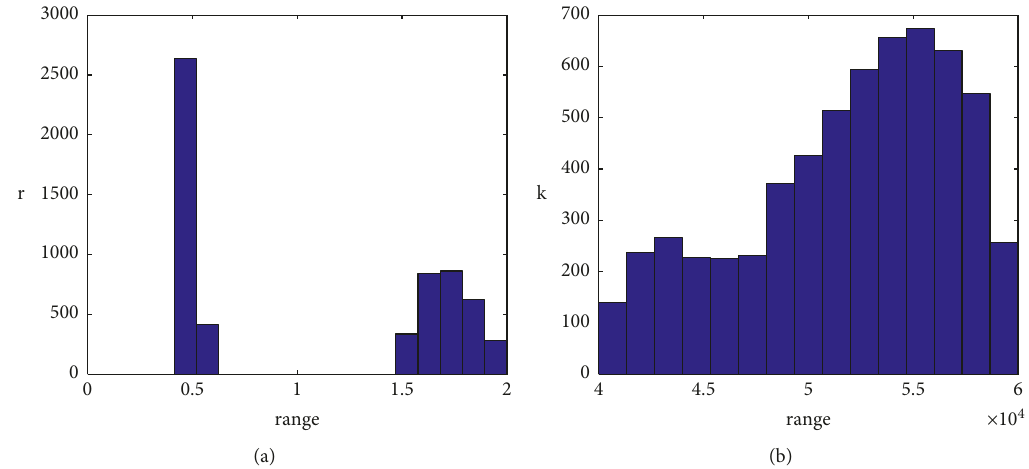
Figure 5: Model parameter histograms of ABC-SMC algorithm. (a) Estimation of r . (b) Estimation of K . Here, the initial states are n � 6000 ,x Table 6: Parameter summary statistics of ABC-SMC